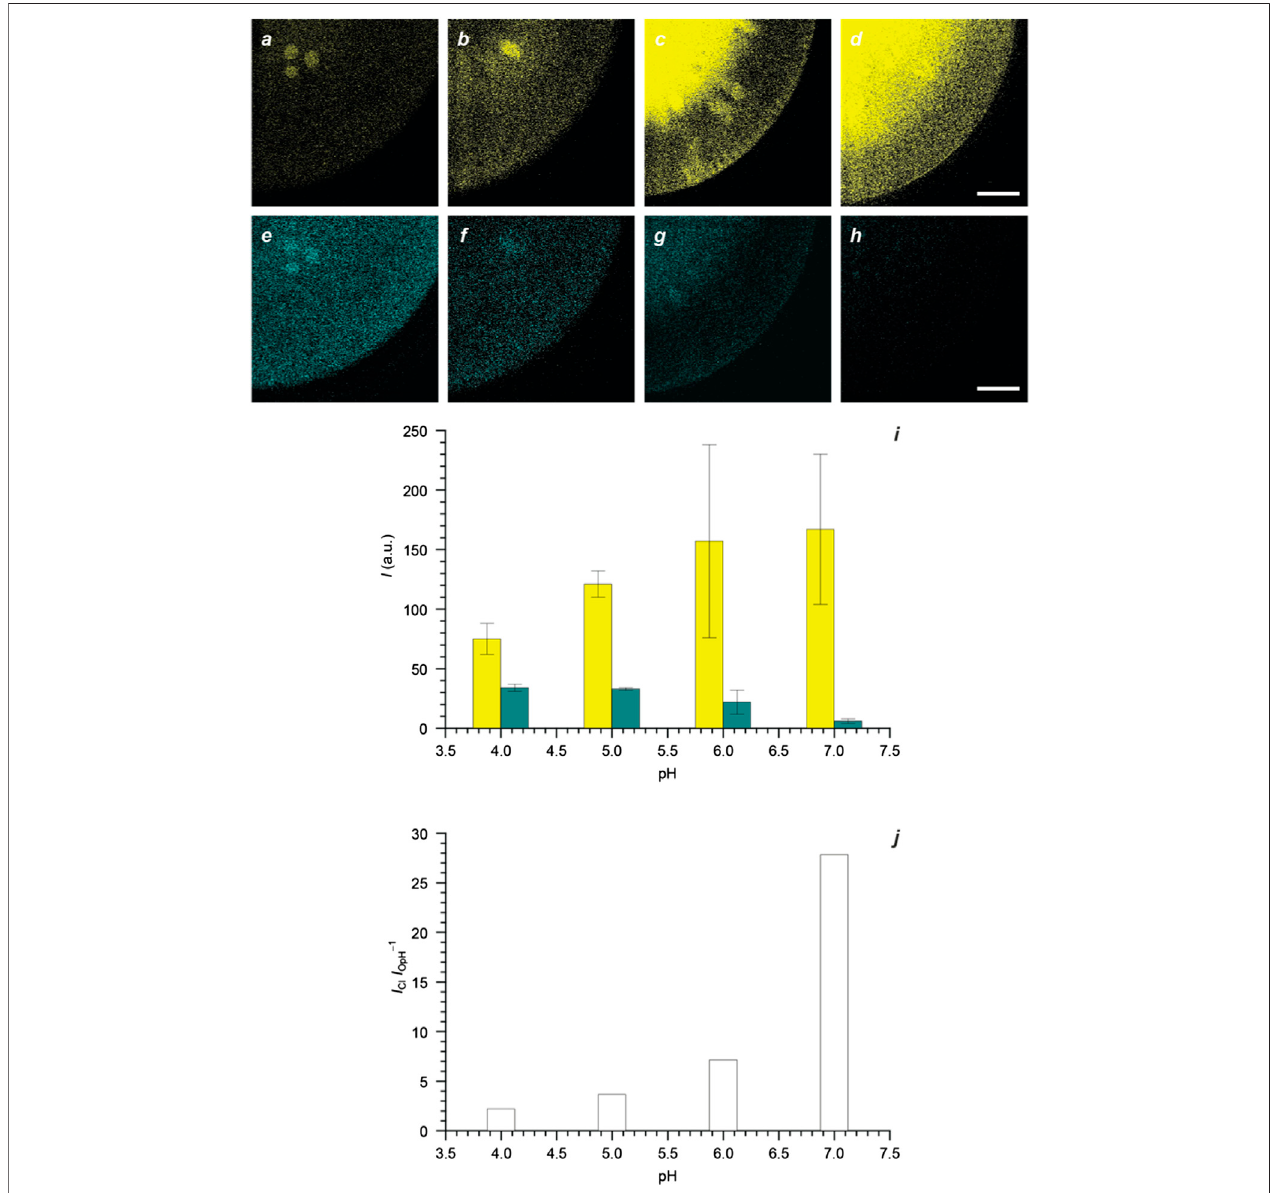
FIGURE 5 | Fluorescence images (scale bar (cid:1) 200 μ m) of four alginate beads doped with Pluronic 123 nanoparticles (1.5 mg mL − 1 ) containing 4 (5 μ M) and